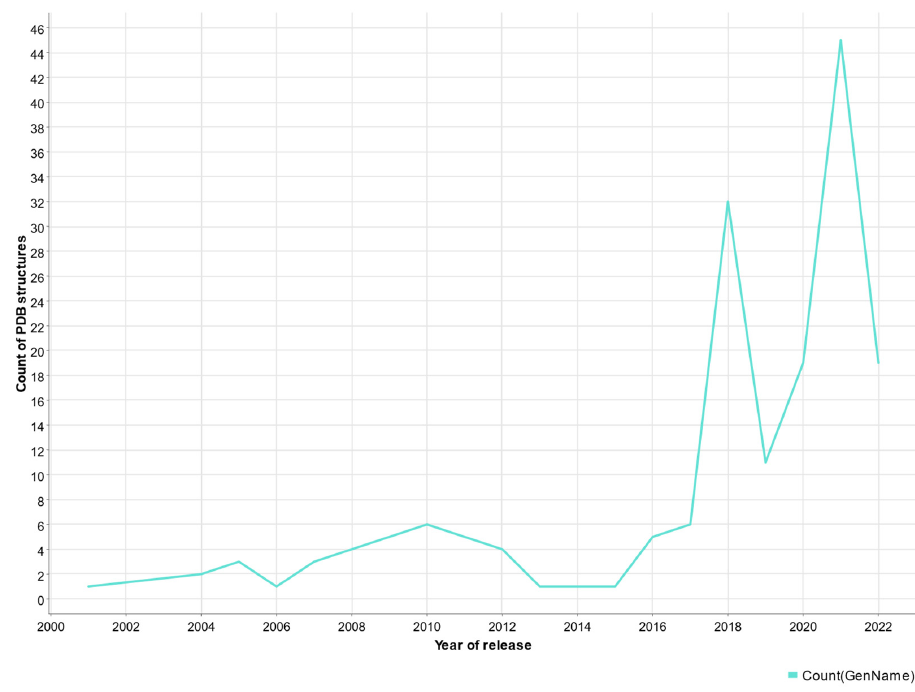
Figure 6. Plot of the number of experimentally solved structures vs. the year of release.